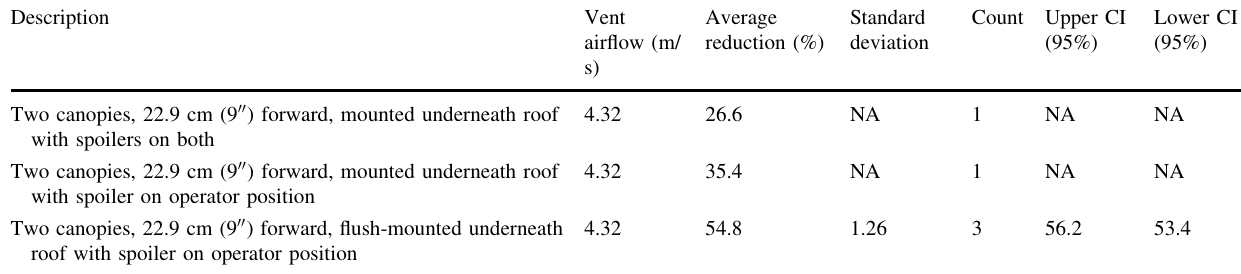
Table 5 Dust control reduction and associated statistics for center-drive shuttle car for an improved canopy configuration shown in Fig. 11